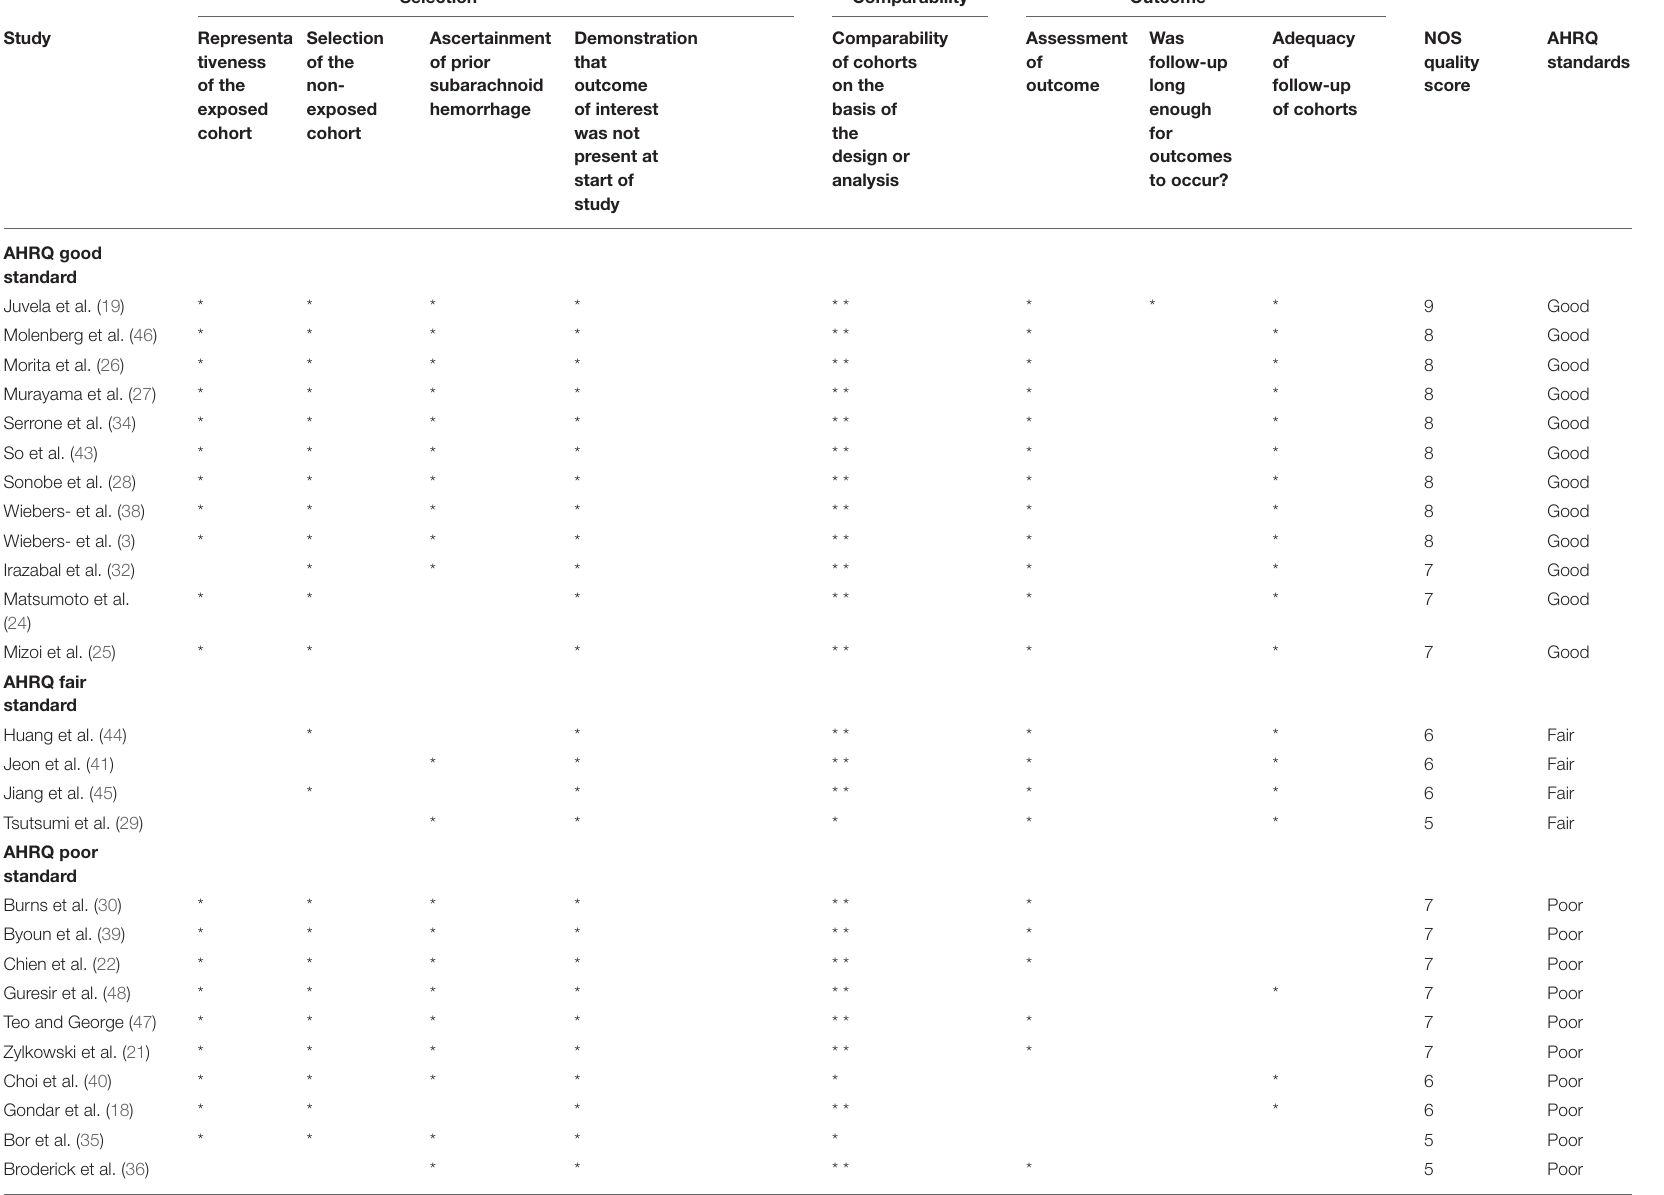
TABLE 2 | Risk of bias